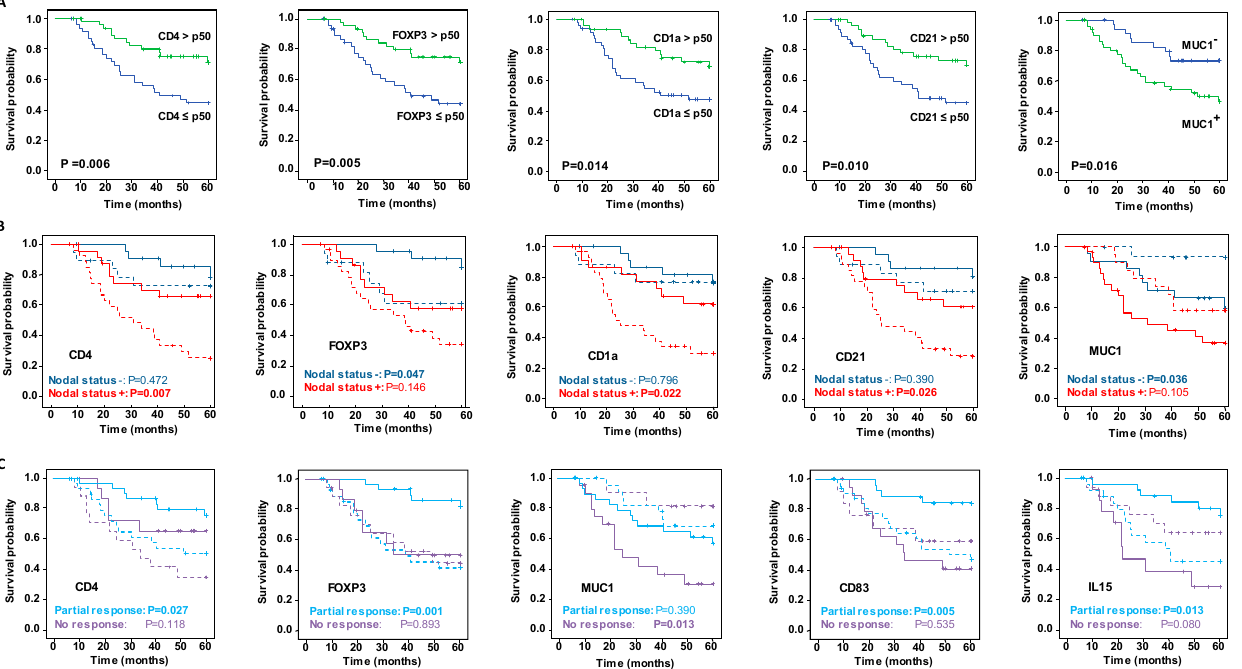
Figure 1. Kaplan–Meier analysis of five-year survival probability with respect to significant immuno- histochemistry (IHC) and mRNA marker expression. ( A ) Kaplan–Meier analysis of overall survival (OS) among all patients. ( B ) Superimposed Kaplan–Meier curves of survival probability stratified by nodal status at diagnosis, and ( C ) depending on the type of response to neoadjuvant chemotherapy. In the plots in B and C, the continuous lines show the OS of patients with IHC immune marker concentrations greater than the median of all patients or when mRNA markers were expressed, and the dashed lines show the OS when IHC immune marker concentrations were less than the median of all patients or when the mRNA markers were not expressed. Significance of the log-rank test is indicated in the figures, with significant differences between variables indicated by probabilities highlighted in